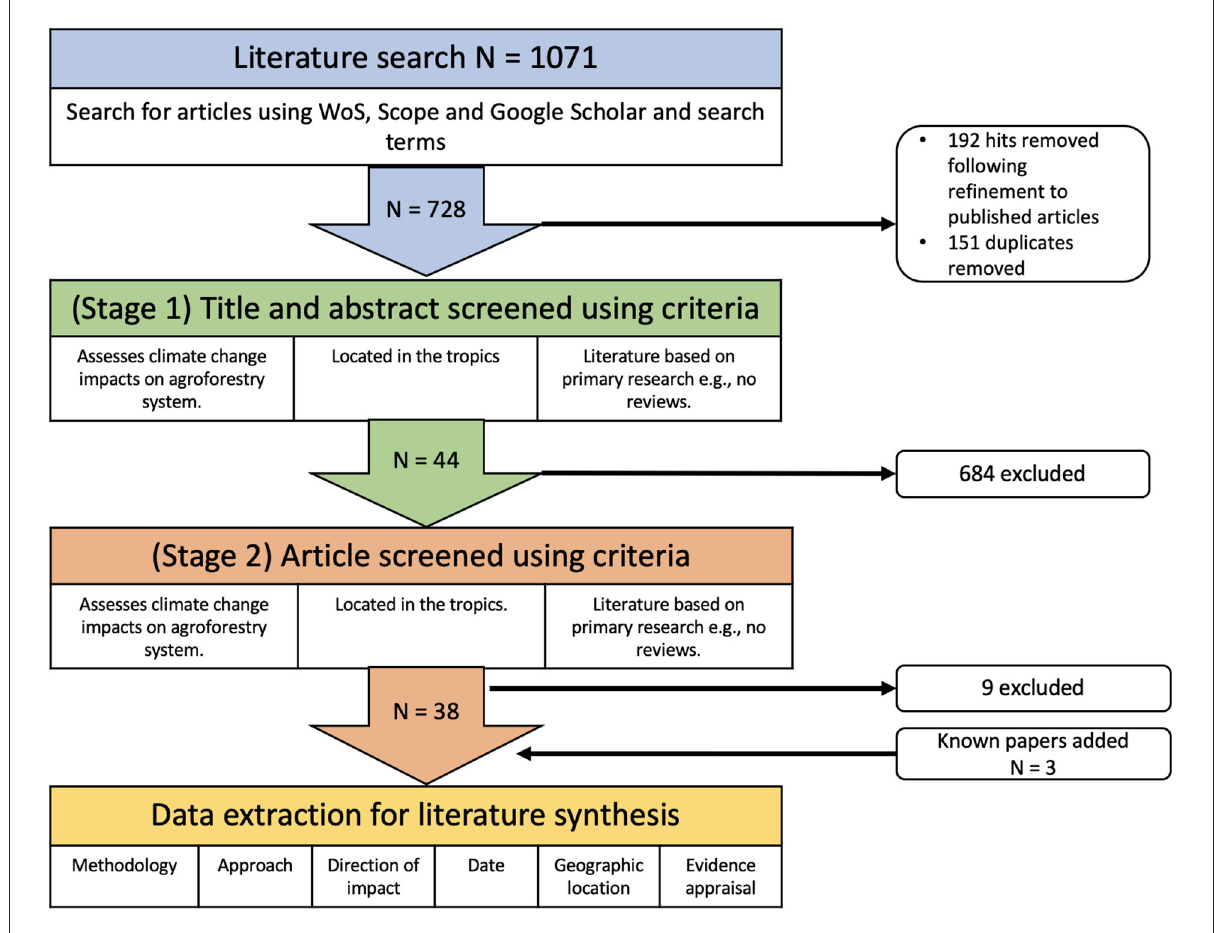
FIGURE1 Schematic review processes of systematic literature